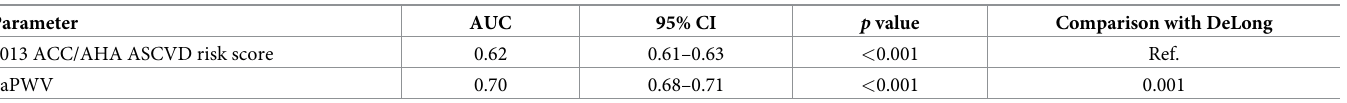
Table 2. Receiver operating characteristic curve